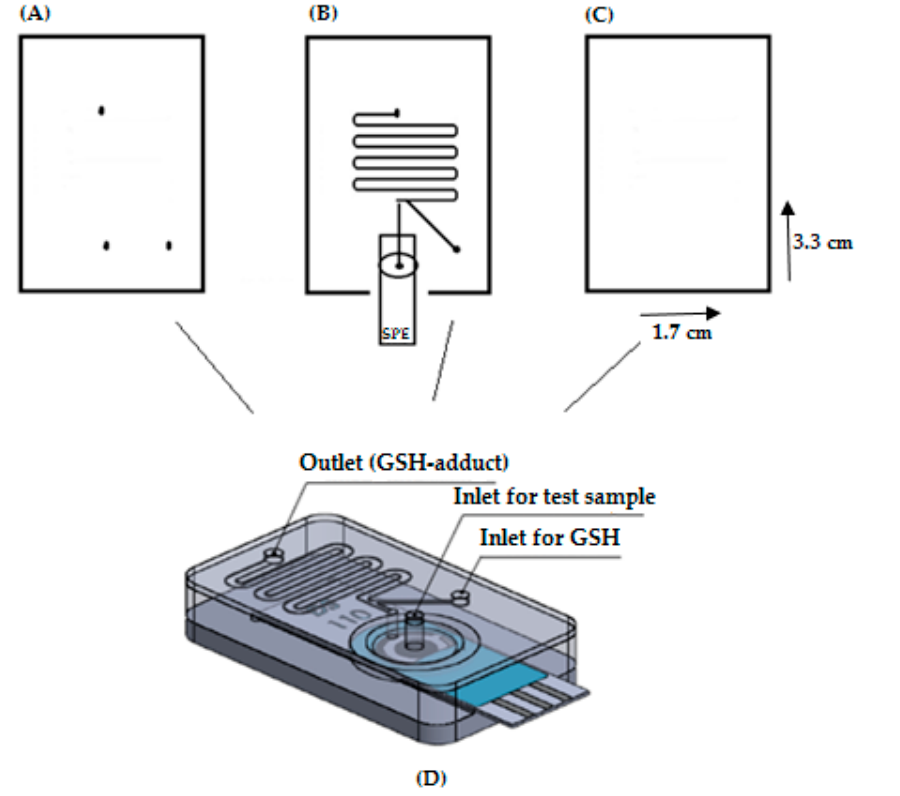
Figure 2. Fabrication process. ( A ) Top wafer with inlets and outlet; ( B ) middle wafer containing the 32 µL SPE cell and 20 µL serpentine reaction channel; ( C ) base layer and ( D ) full design of the chip.